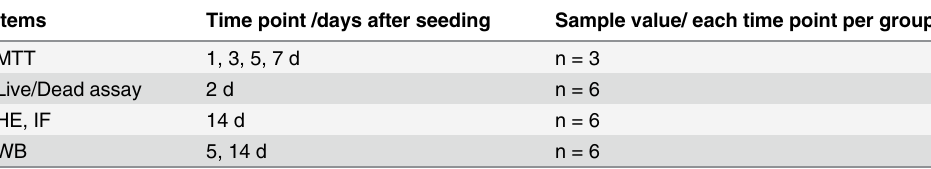
Table 1. Designated time points and sample